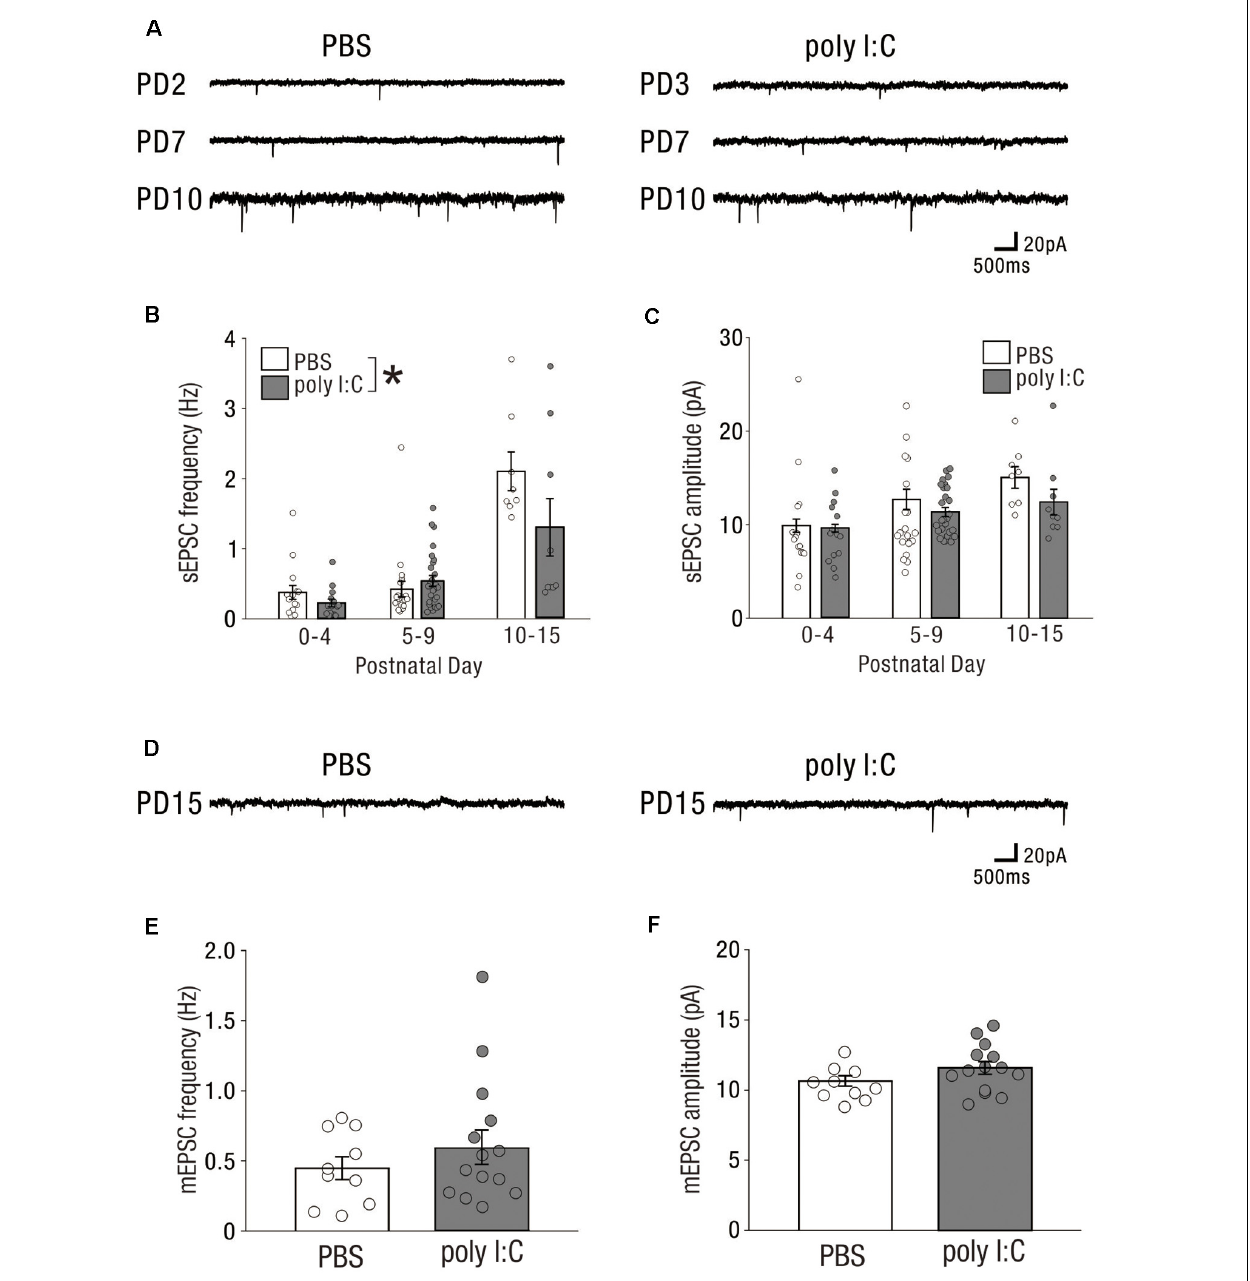
FIGURE 3 | In the early postnatal period, prenatal poly I:C treatment partially affects excitatory drive onto CA1 pyramidal cells. (A) Representative data of sEPSCs recorded from a CA1 pyramidal cell of a PBS-treated mouse (left) and poly I:C-treated mouse (right) in each PD during the neonatal period. (B) There was a significant difference in sEPSC frequency between PBS-treated and poly I:C-treated mice. (C) There was no significant difference in sEPSC amplitude between PBS-treated and poly I:C mice. (D) Representative data of mEPSCs recorded from a CA1 pyramidal cell of a PBS-treated mouse (left) and poly I:C-treated mouse (right) in each PD during the neonatal period. (E,F) There were no significant differences in mEPSC frequency and amplitude between PBS-treated and poly I:C-treated mice, * p < 0.05. Data are presented as means, and error bars indicate SEM. Poly I:C, polyriboinosinic-polyribocytidilic acid; PBS, phosphate-buffered saline; sEPSC, spontaneous excitatory postsynaptic current; mEPSC, miniature excitatory postsynaptic current.